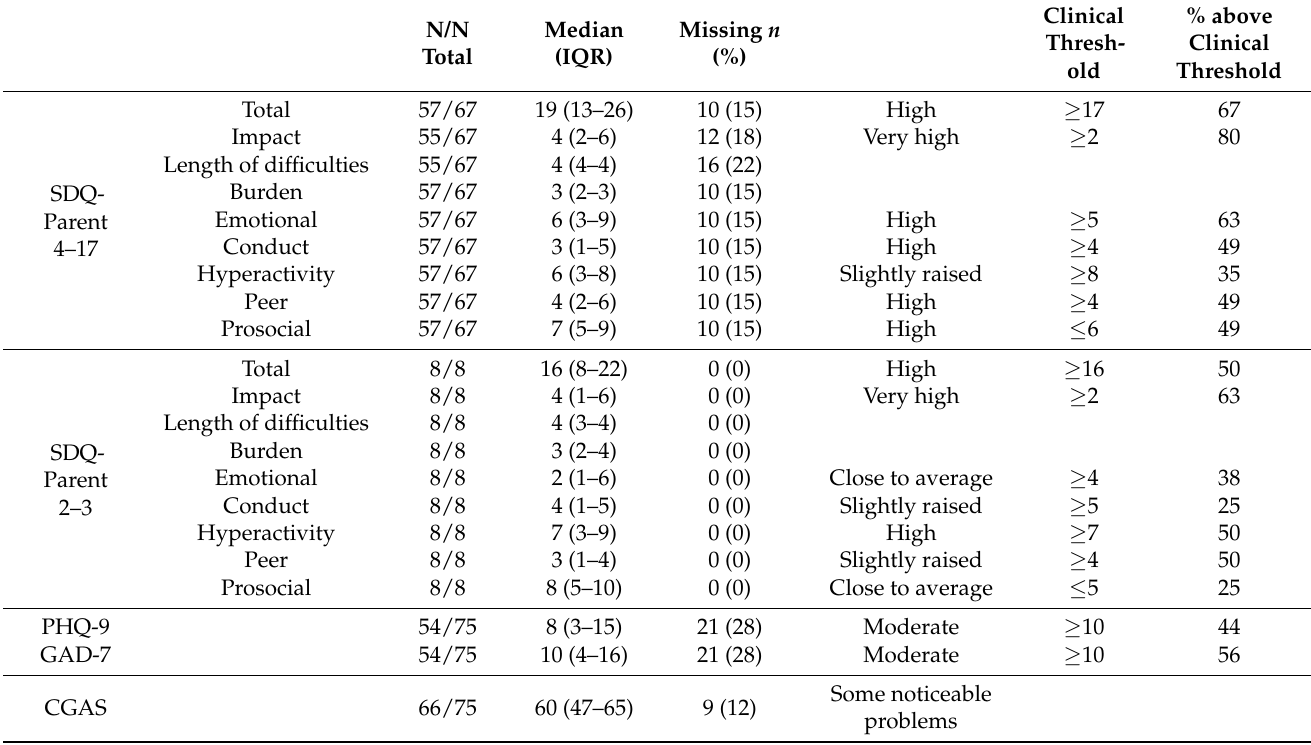
Table 2. Participant symptoms. The median and interquartile range (IQR) for participants’ symptoms are presented for the parent report SDQ (2–3 years and 4–17 years) and GAD-7/PHQ-9 along with the corresponding clinical threshold and percentage of participants/parents above the clinical threshold. Clinical thresholds for the SDQ are taken from the newer four-band categorisation based on the parent completed version of the